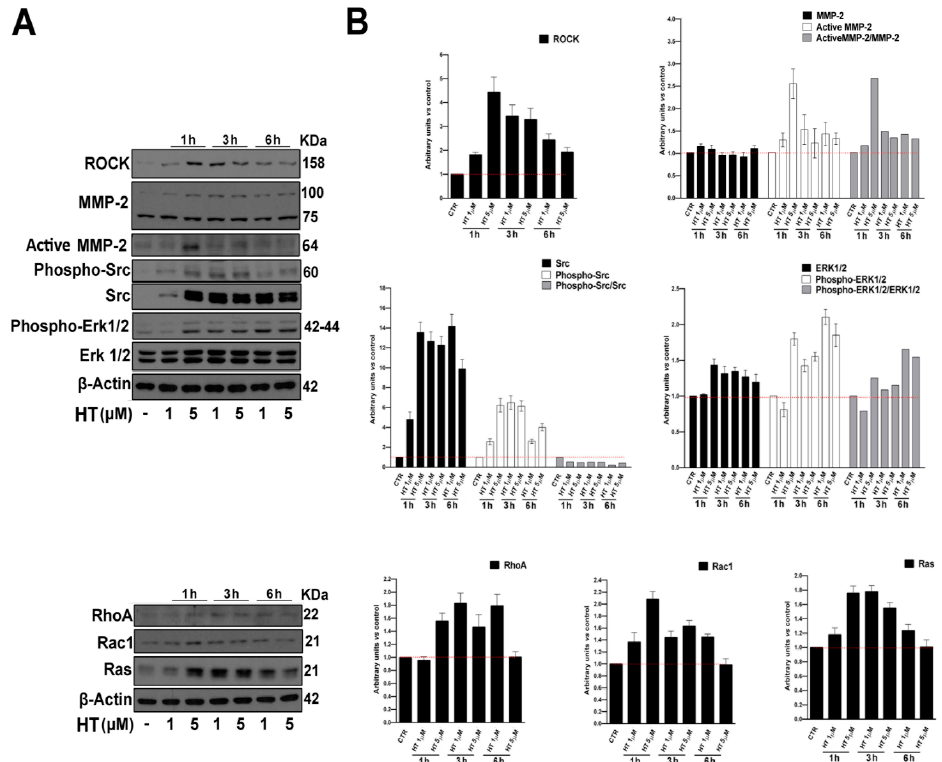
Figure 3. HT induces migration proteins expression in HUVEC cells. ( A ) Western blot analysis